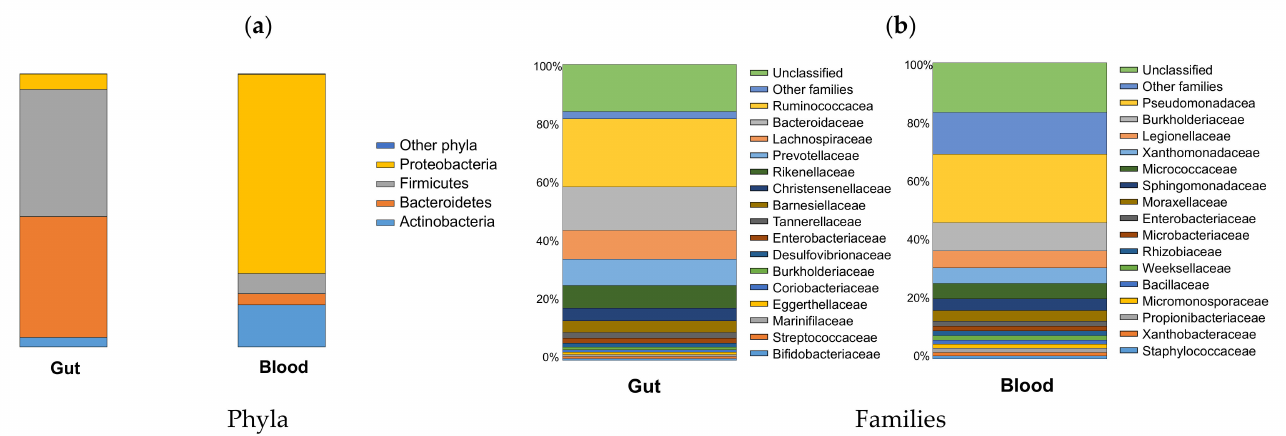
Figure 2. Relative abundance of bacteria phyla ( a ) and family ( b ) in the gut and blood microbiome in chronic kidney disease patients on peritoneal